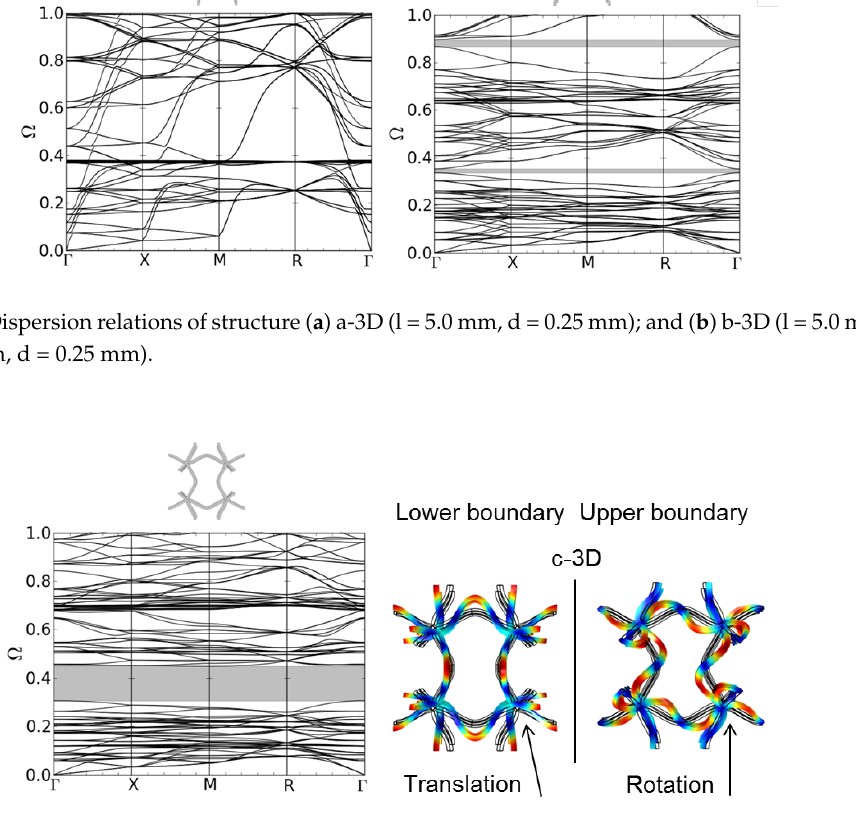
Figure 8. Dispersion relations of structure c-3D (l = 5.0 mm, A = 1.0 mm, d = 0.25 mm) and corresponding mode shapes at the lower and upper boundary of the first band